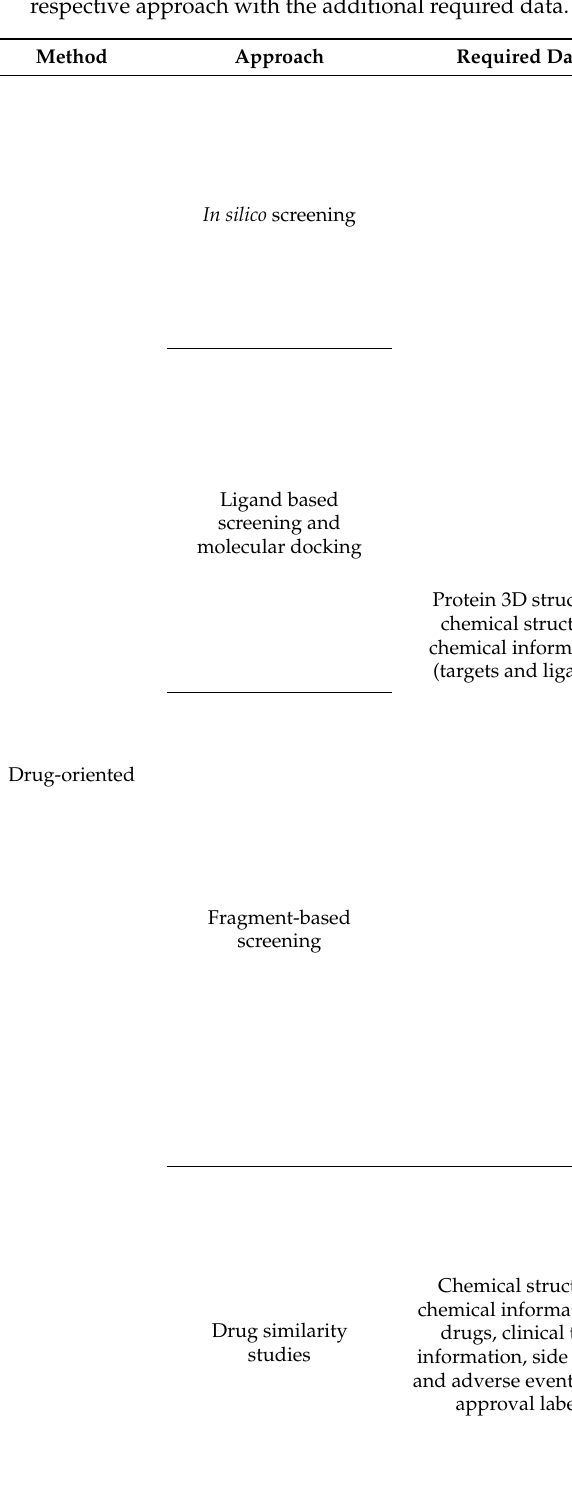
Table 3. List of software tools for the in silico drug repurposing studies (neither extensive nor exhaustive) based on the respective approach with the additional required